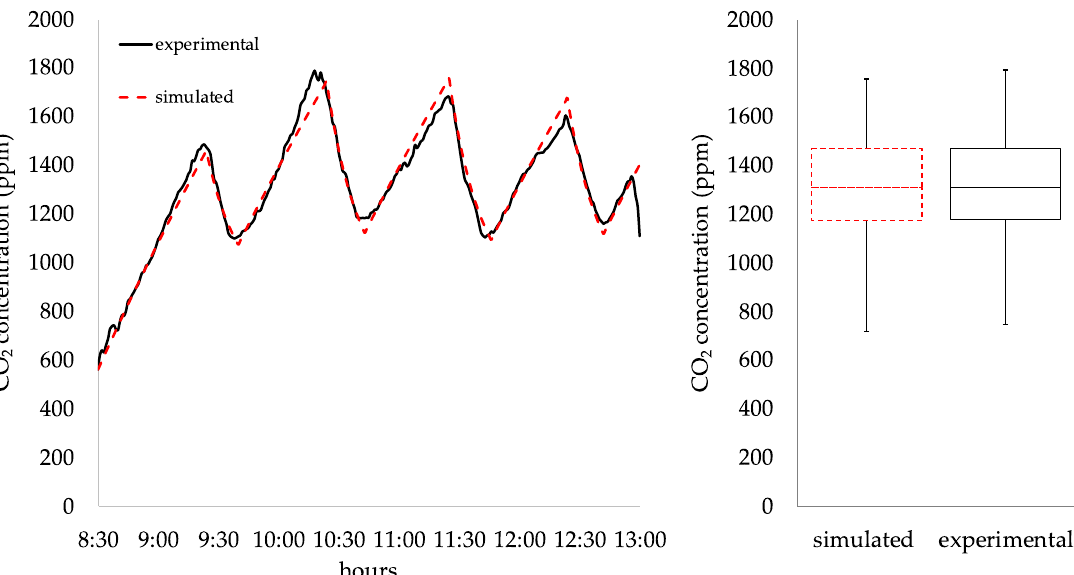
Figure 6. Comparison between the CO 2 concentration (trends and box-plots) measured (experimental) and simulated through the mass balance equation for the manual airing test with scheduled window openings of 15 min every hour (MA 2)